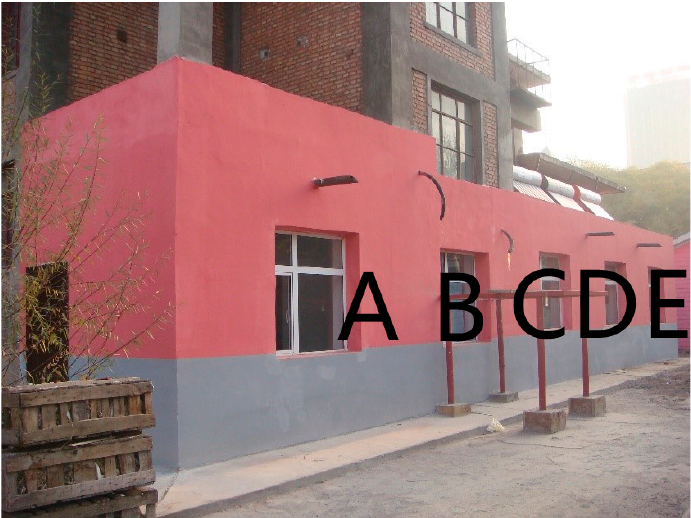
Figure 1. The experimental platform in this work.